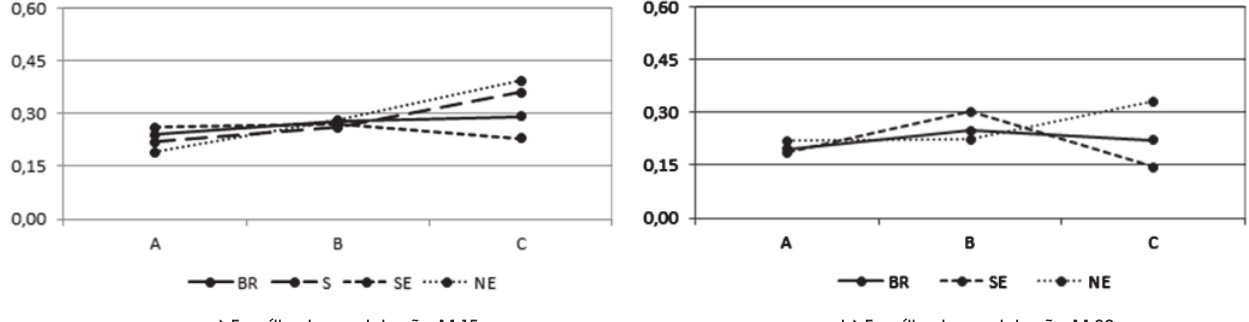
Coeficiente de variação (C.V.) da resistência em relação às famílias de